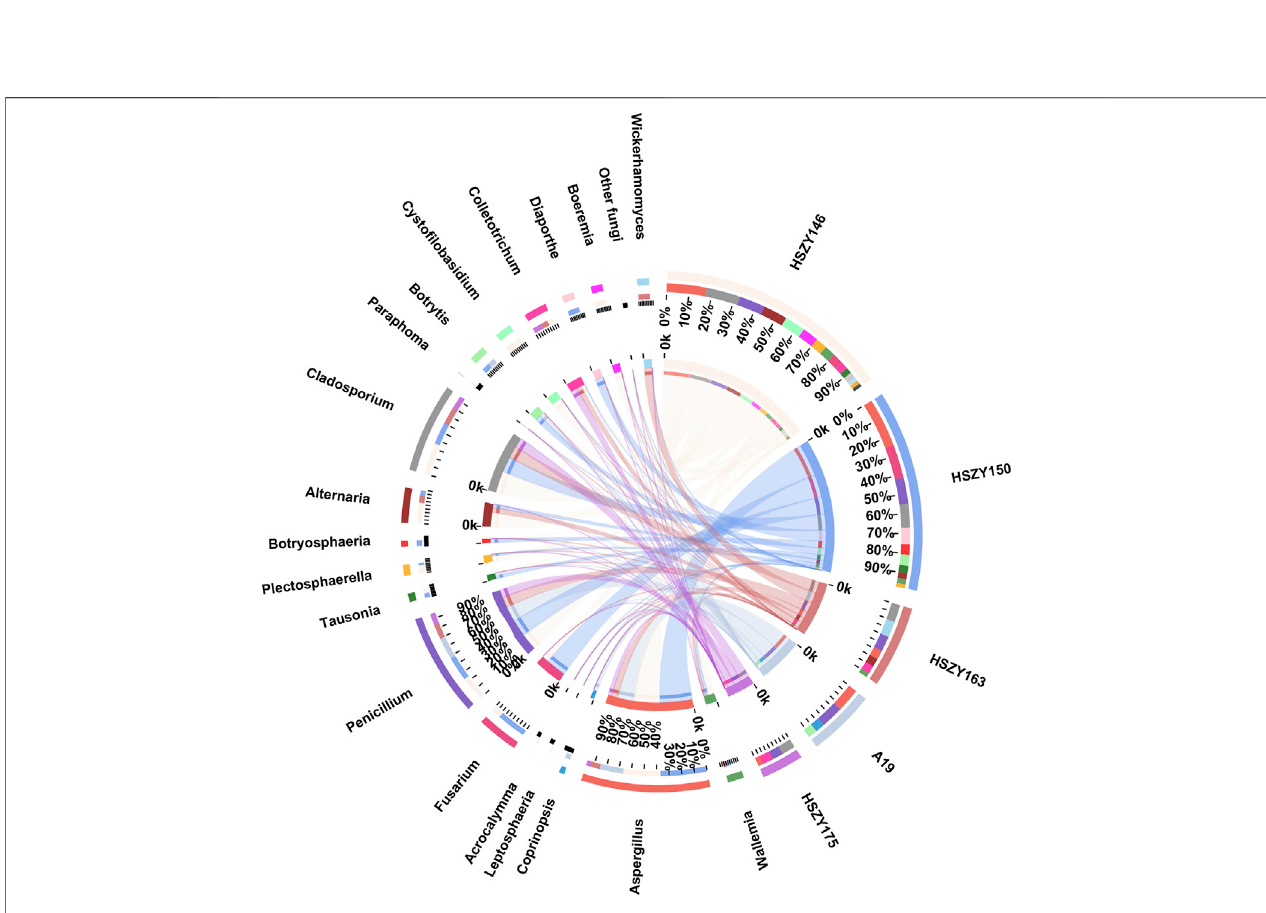
FIGURE 5 | Distribution of the fungi for each sample at the genus level. The data were visualized by Circos. The left half-circle indicates the distribution ratio of species in different samples at the genus level: the outer ribbon represents the species; the inner ribbon represents different groups, and the length represents the sample proportion of a particular genus. The right half-circle indicates the species composition in each sample: the color of the outer ribbon represents samples from different groups; the color of the inner ribbon represents the composition of different species in each sample, and the length of the ribbon represents the relative abundance of the corresponding species (Guo et al.,